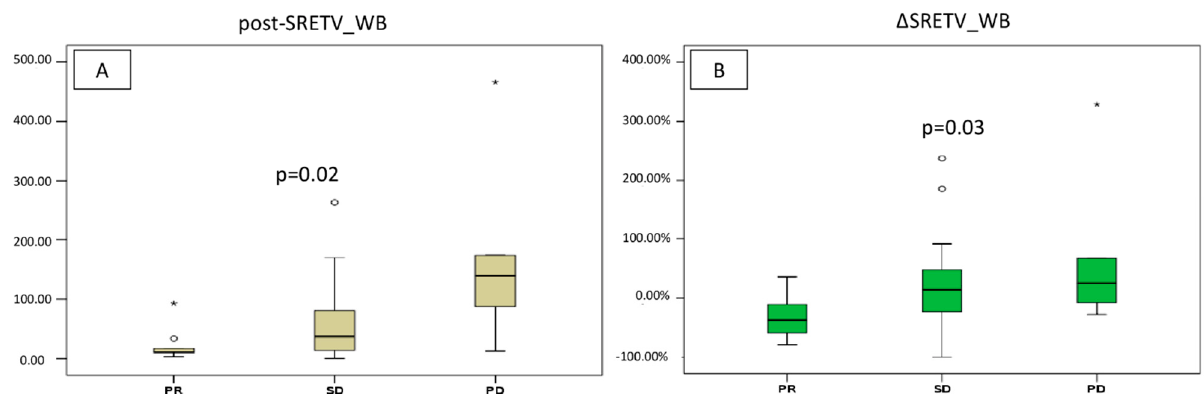
Figure 2. Graphical box-plots representing median values of somatostatin receptor expressing tumor volume (SRETV) for total tumor burden (_WB) at first restaging ( A ) and according to variation between baseline and restaging ( ∆ ) ( B ). Both median values were significantly different among response categories. Outliers and extremes are represented by ◦ and *, respectively.